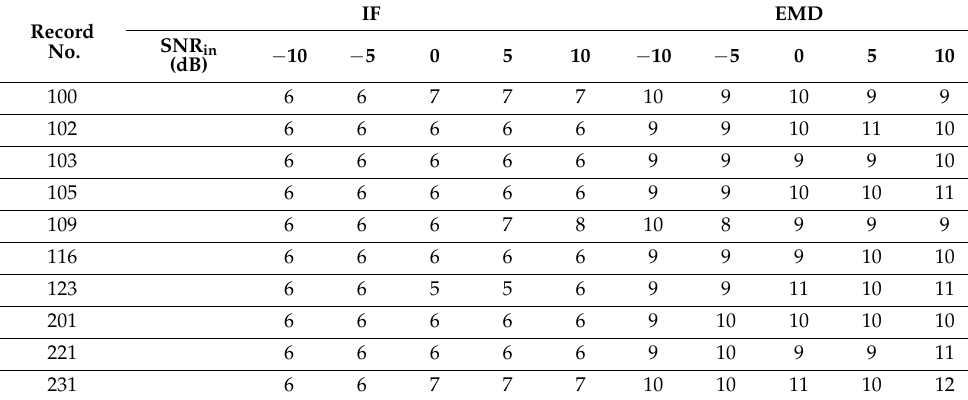
Table 1. Comparison between IF and EMD in terms of the number of IMFs generated at various input SNR values.